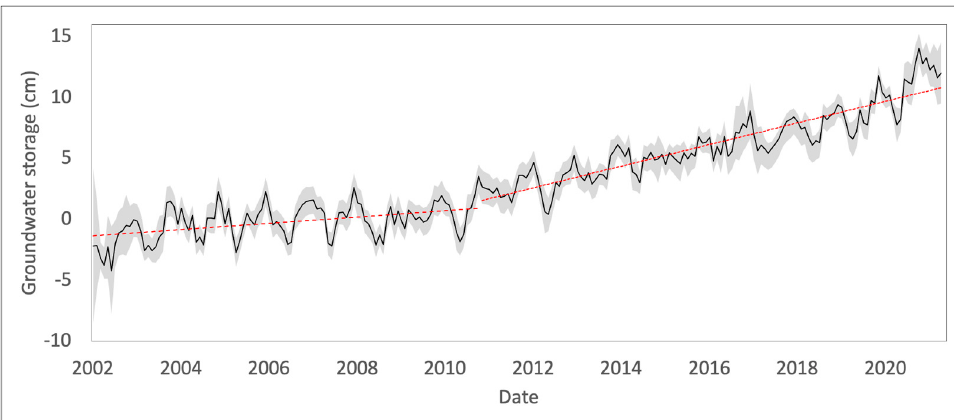
Figure 10. Groundwater storage anomalies in the Iullemeden basin region.